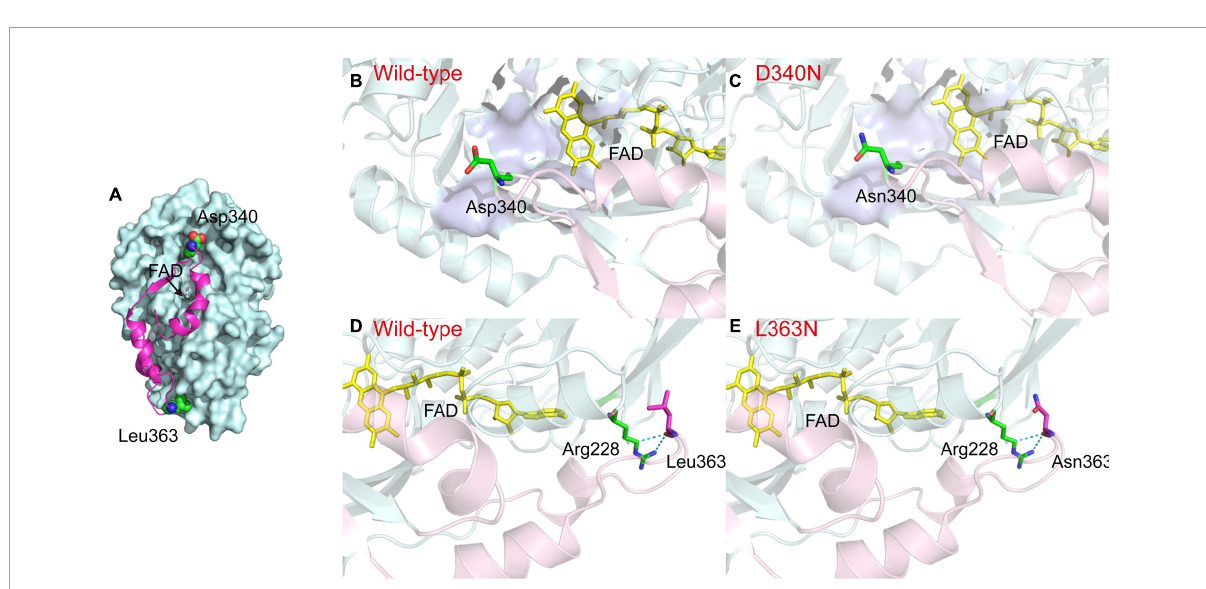
FIGURE6 Comparison between the structures of L -amino acid deaminase ( L -AAD) and mutants. (A) The overall structure of L -AAD. The INS region was shown as the magentas cartoon. (B–E) The difference of side chain in L -AAD and mutants. The INS was shown as the cartoon by light pink and the rest of the protein was colored by light blue. The active sites of L -AAD were mod-eled based on the crystallographic structures (PDB: 5hxw, the active center was shown as the surface in purple blue). The mutant residues were represented as sticks and H-bond was shown as the dotted